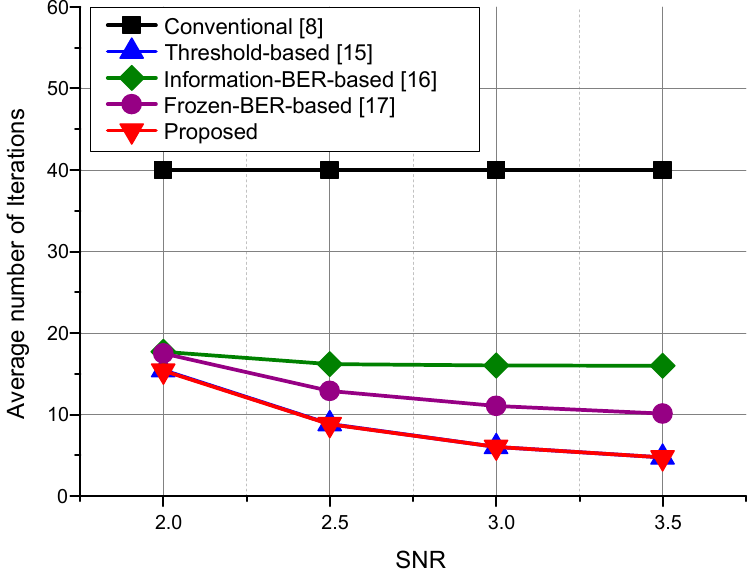
Figure 7. Average number of iterations for different early-termination methods.